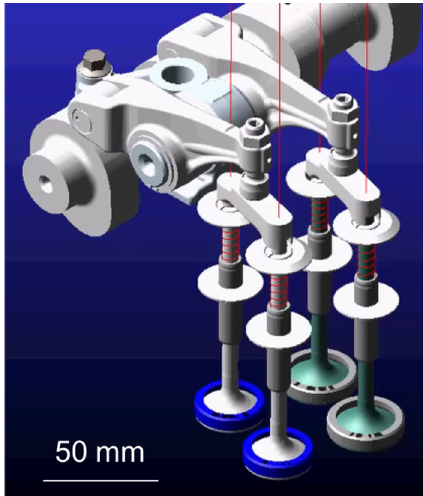
Fig. 6. ADAMS rigid body